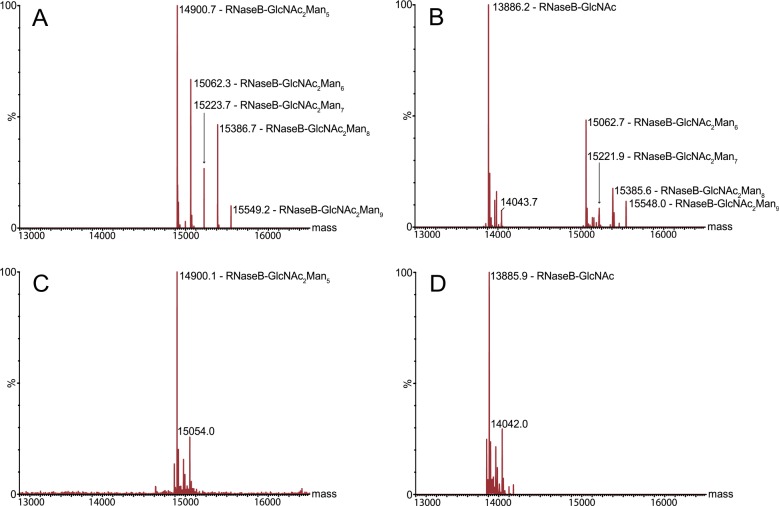
Deglycosylation of RNase B by SpGH92 and EndoD.(A) Reconstructed mass spectrum of native RNaseB. The following glycoforms are observed: RNaseB-GlcNAc2Man5 (exp: 14899.4 Da, obs: 14900.7 Da), RNaseB-GlcNAc2Man6 (exp: 15061.6 Da, obs: 15062.3 Da), RNaseB-GlcNAc2Man7 (exp: 15223. Da, obs: 15223.7 Da), RNaseB-GlcNAc2Man8 (exp: 15386.0 Da, obs: 15386.7 Da) and RNaseB-GlcNAc2Man9 (exp: 15548.2 Da, obs: 15549.2 Da). (B) EndoD cleaves the chitobiose core of Man5GlcNAc2, yielding RNaseB-GlcNAc (exp: 13885.2 Da, obs: 13886.2 Da), but cannot act on the Man6-Man9 glycoforms. (C) SpGH92 trims the Man6-Man9 glycoforms down to the RNaseB-GlcNAc2Man5 glycoform (exp: 14899.4 Da, obs: 14900.1 Da). (D) Together, SpGH92 and EndoD act on all glycoforms of RNase B to produce exclusively RNaseB-GlcNAc (exp: 13885.2 Da, obs: 13885.9 Da).